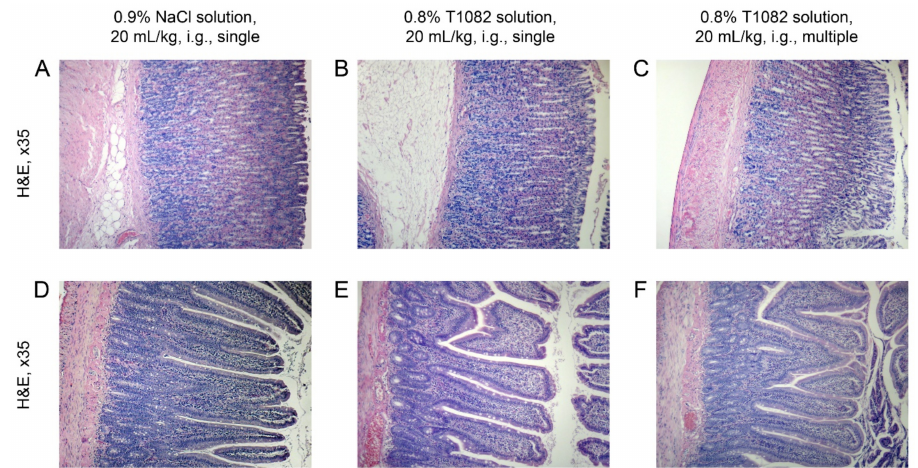
Figure 7. The effect of compound T1082, at a dose of 160 mg/kg, i.g., by single and multiple administration, on the histology picture of the tissues of the greater curvature of the stomach ( A – C ) and jejunum ( D – F ) on the 11th day after last administration (H&E; × 35). ( A , D ) A rat that received a single administration of 0.9% sodium chloride solution at a dose of 20 mL/kg. The histological structure of the tissues of stomach and jejunum corresponds to the age norm. ( B – E ) A rat that received a single administration of 0.8% T1082 solution at a dose of 20 mL/kg. The histological structure of all layers of the wall of the stomach and the wall of the jejunum corresponds to the norm. ( C –F) A rat that received a multiple administration of 0.8% T1082 solution at a dose of 20 mL/kg. Pathological changes in the histostructure of the stomach and jejunum were not